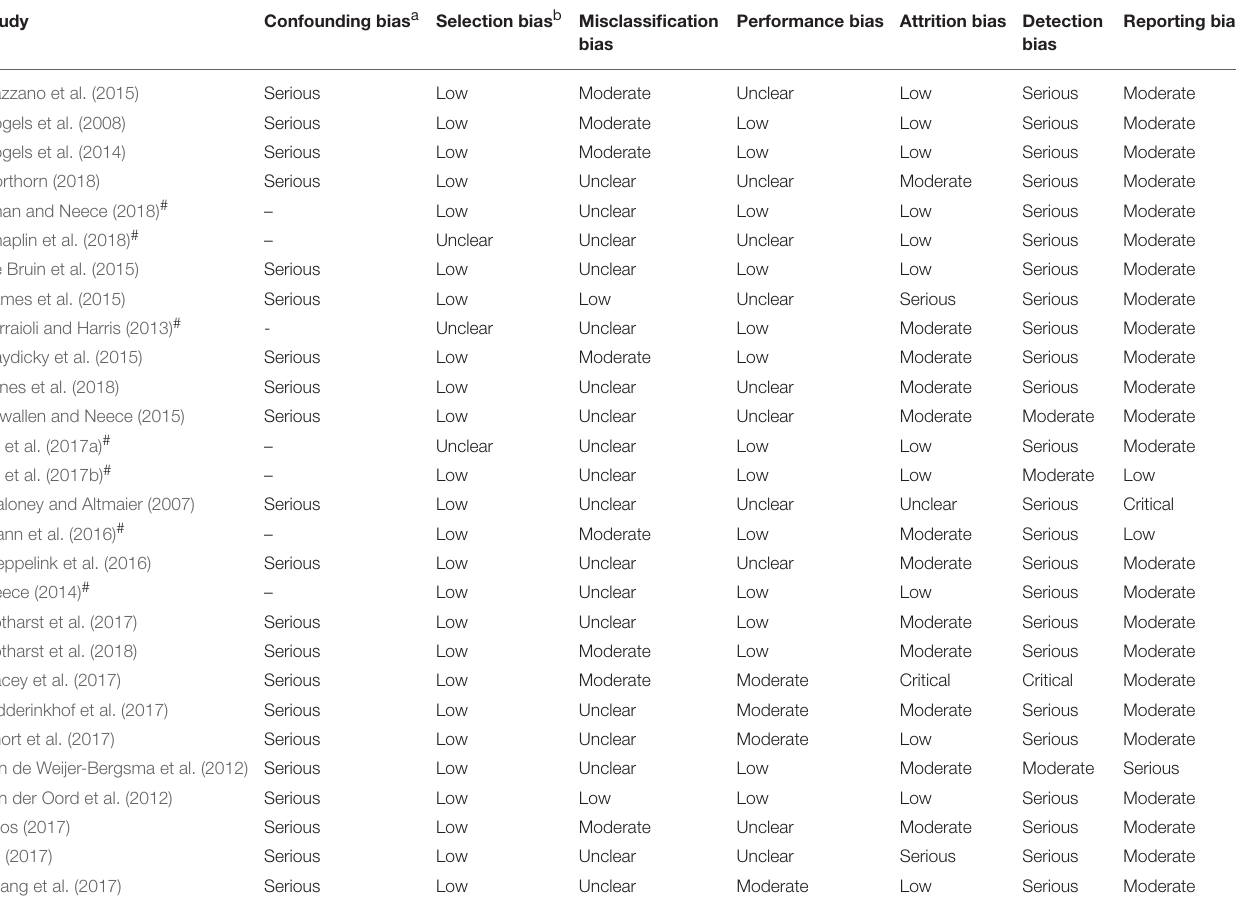
TABLE 5 | Risk of bias assessment for reviewed